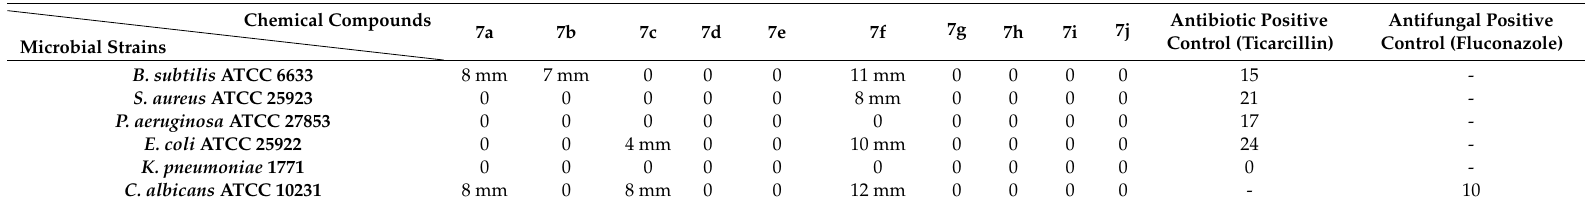
Table 4. The results of the qualitative assay of the antimicrobial activity of the tested compounds by using an adapted di ff usion assay (the growth inhibition diameters were measured and expressed in mm).